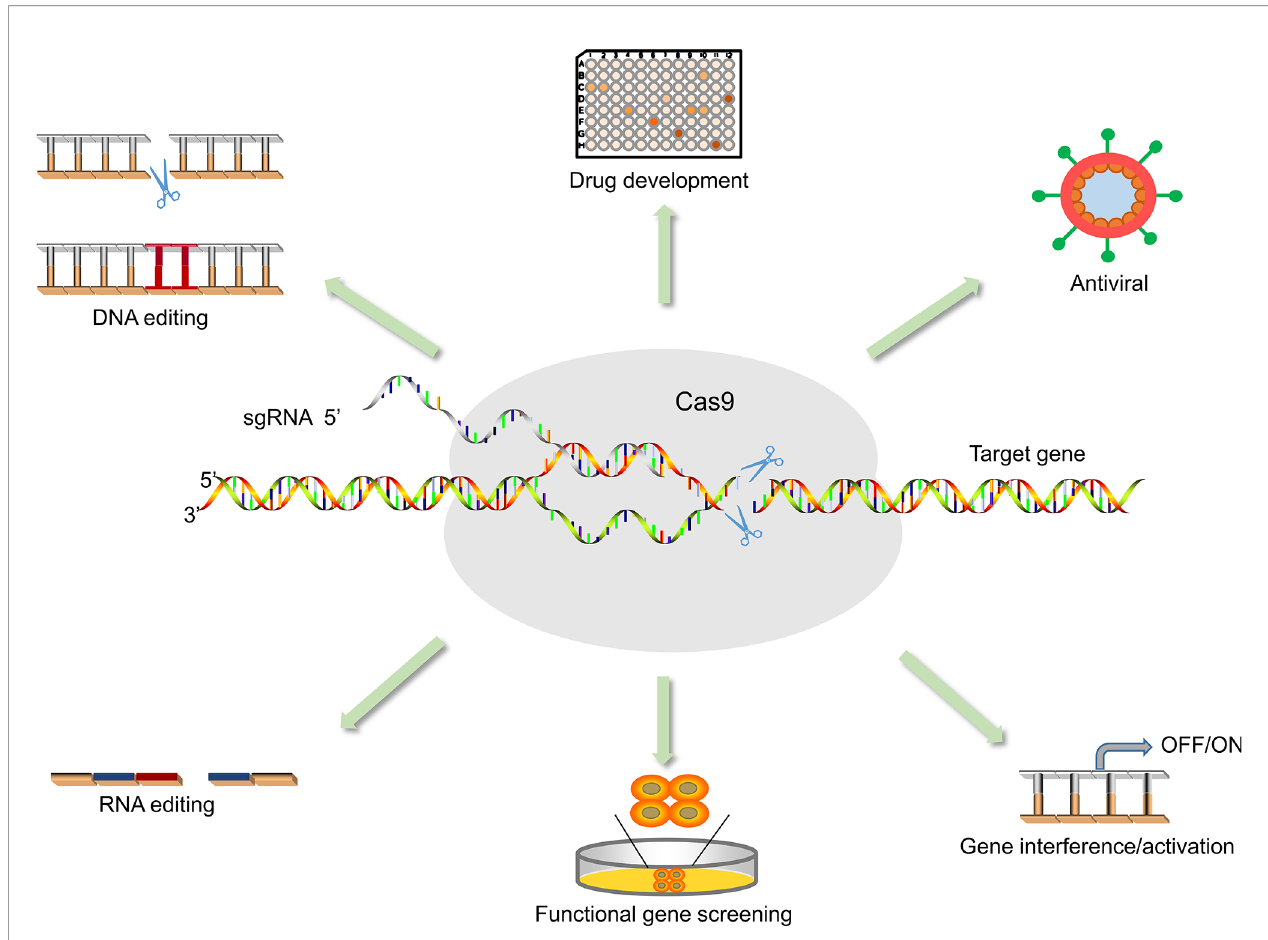
FIGURE 3 | Application of CRISPR/Cas9 in medical sciences. The application of Cas9 is not only for antiviral but also for functional gene screening, drug development, animal model vector construction, and signaling pathway